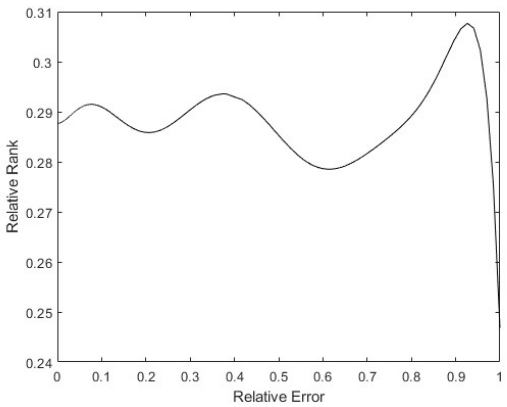
Figure 28. Polynomial regression of relative rank to relative error on X 2 .